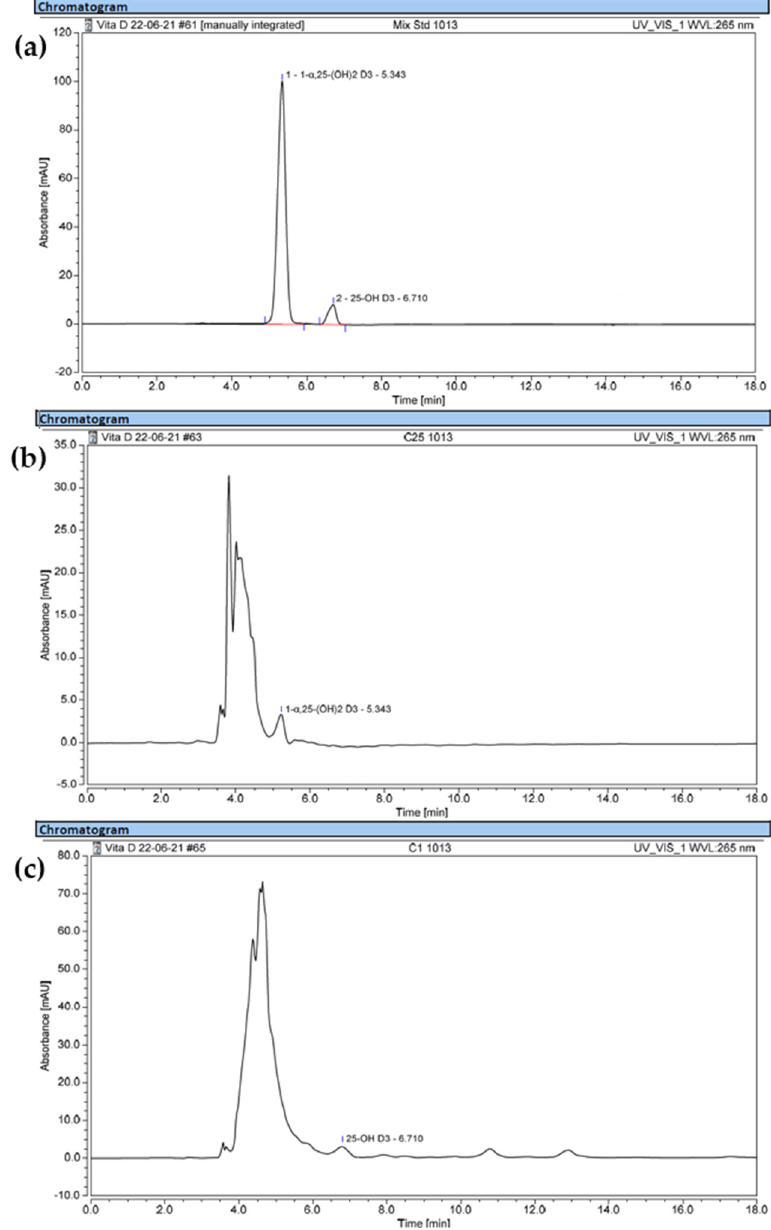
Figure 1. ( a ) HPLC chromatogram of 1 α ,25-(OH) 2 D 3 and 25-OHD 3 standards mixtures; ( b ) HPLC chromatogram of purified sample tube 25 showing 1 α ,25-(OH) 2 D 3 identification peak; ( c ) HPLC chromatogram of purified sample tube 1 showing 25-OHD 3 identification peak.